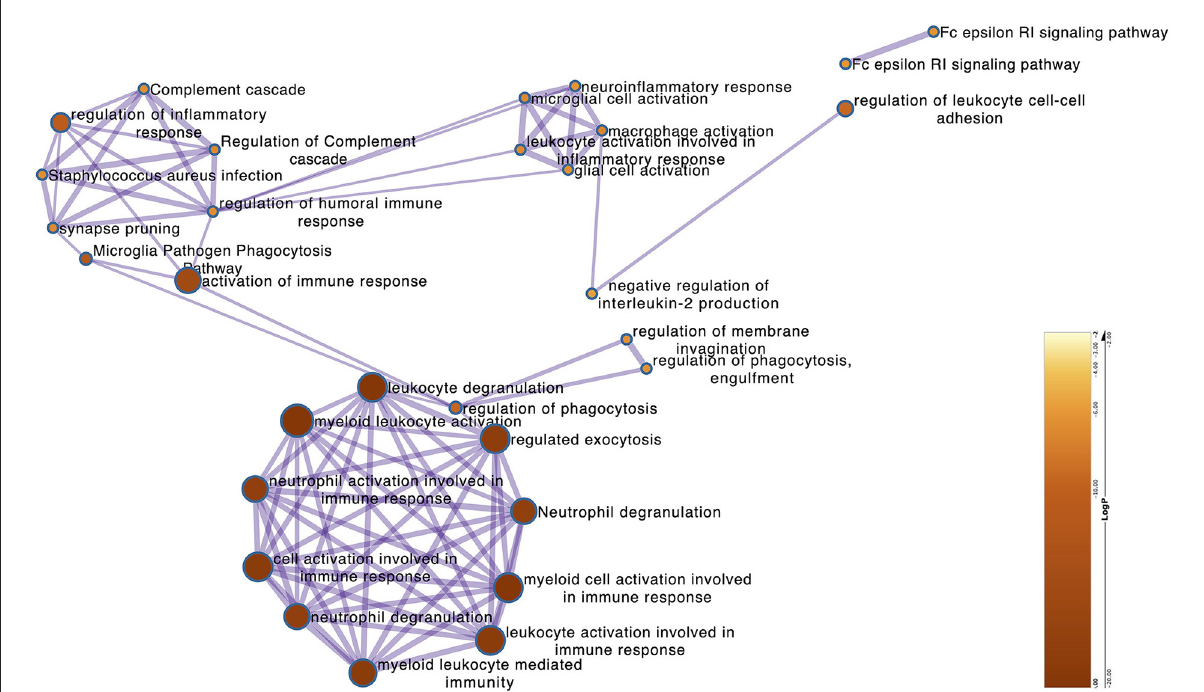
FIGURE4 The Metascape of the overlapping genes. The network shows the GO terms that the log P ( − 23 to − 8) correlates with the significance of the enrichment.